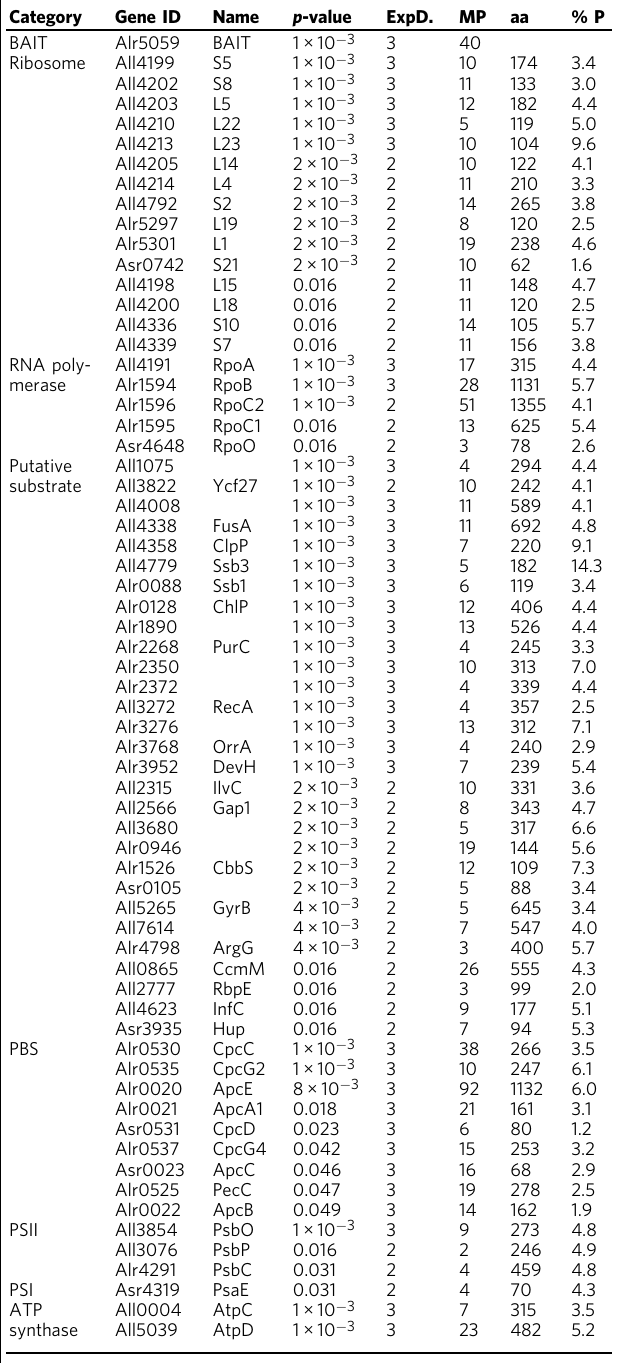
Table 1 Proteins detected to interact with ana